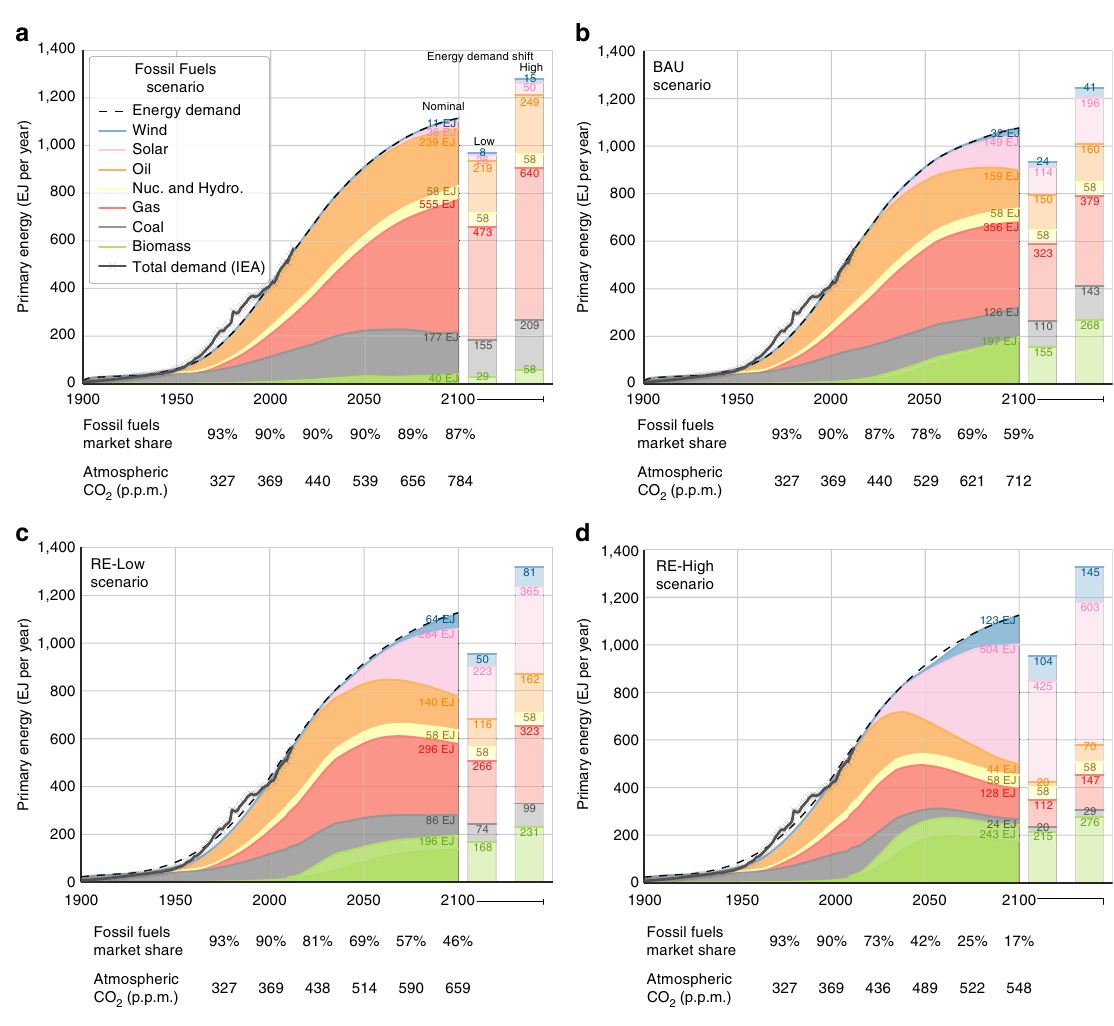
Figure 2 | Time series of global primary energy consumption. Nominal demand in the ( a ) Fossil Fuels, ( b ) BAU, ( c ) RE-Low and ( d ) RE-High scenarios is shown as time series in each panel. Energy profiles in year 2100 of alternative pathways, used to determine model sensitivity to primary energy demand, are displayed as columns at right. At bottom, time series of fossil fuel market share (as a percentage of total energy consumption) and atmospheric CO 2 concentration are displayed at quarter-century intervals. Source of historical data on total primary energy demand: International Energy Agency 39